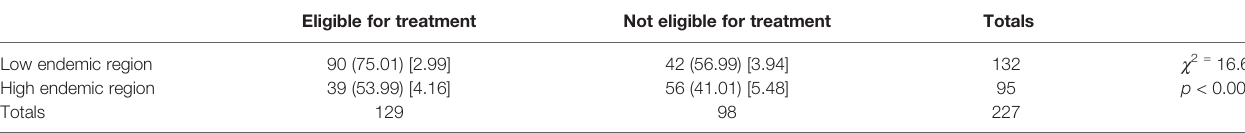
TABLE 2 | 2 × 2 table showing the analysis of treatment eligibility by endemicity using the TREAB-B score of ≥ 2.0 for both low and high endemic regions. Eligible for treatment